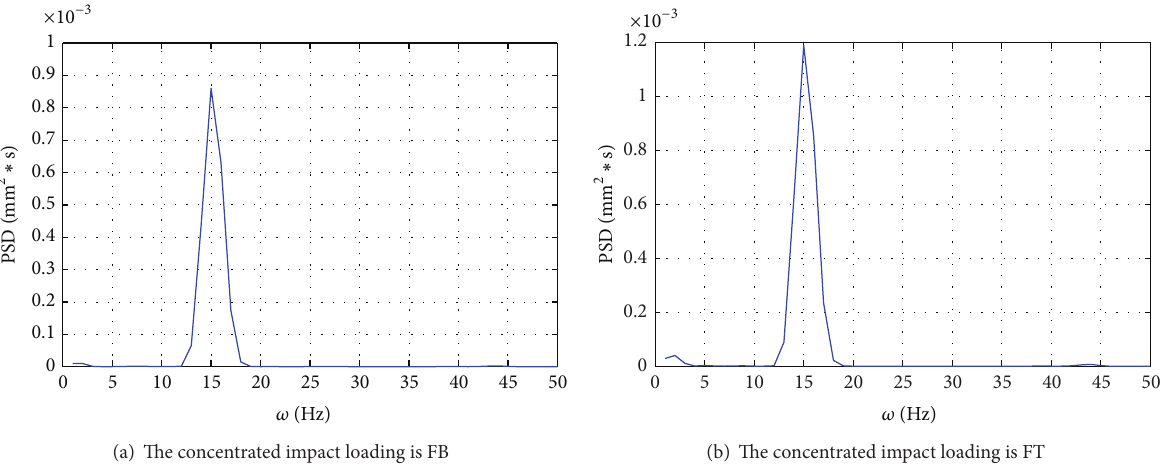
Figure 8: The displacement power spectral density curve of the C1 point for square Heytex membrane under the concentrated impact loading ( 𝐹 0𝑥 = 𝐹 0𝑦 = 1 kN).